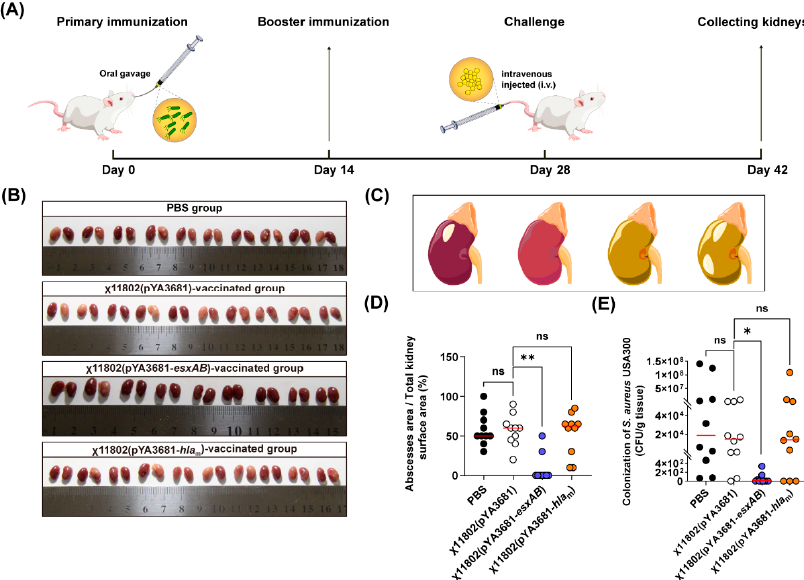
Figure 5. Abscess formation after BALB/c mice were challenged with S. aureus USA300 by i.v. ( A ) Immunization and challenge strategy. ( B ) Abscess formation of BALB/c mouse kidneys. ( C ) Four different degrees of kidney abscess symptoms. ( D ) Abscess area proportion of total kidney surface area. ( E ) Colonization of S. aureus USA300 in the kidneys after BALB/c mice challenge. * p < 0.05; ** p < 0.01; ns, no significance.